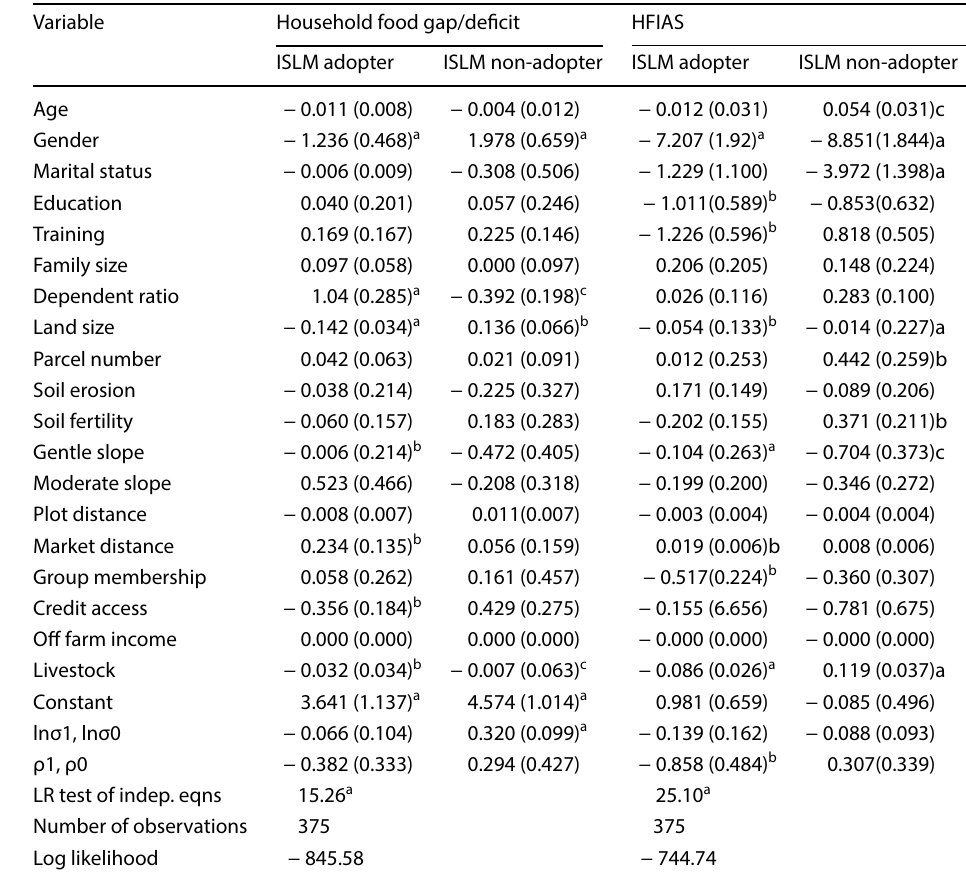
Table 4 ESR results for food gap and household food insecurity